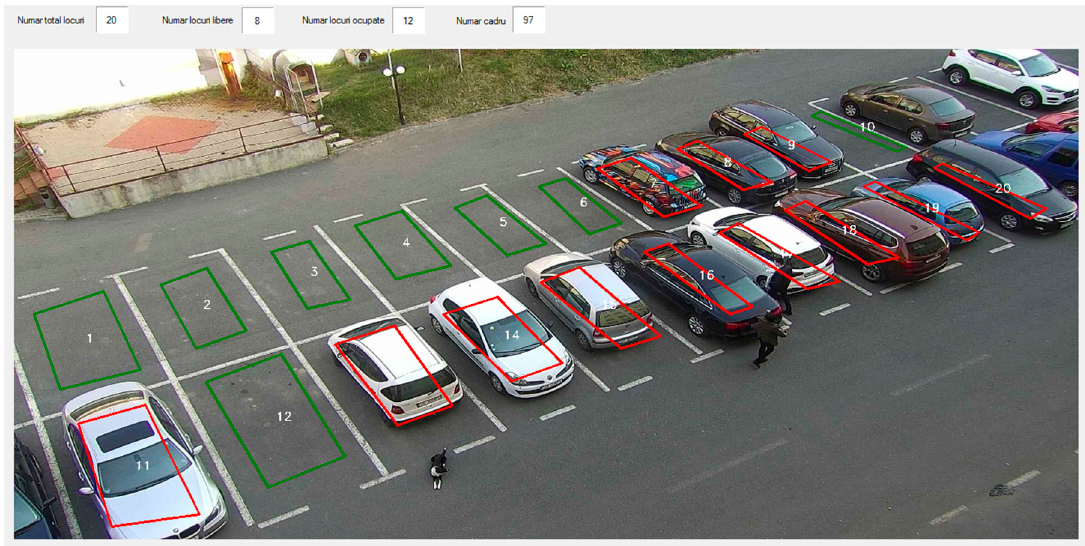
Figure 10. A result sample from benchmark 2.